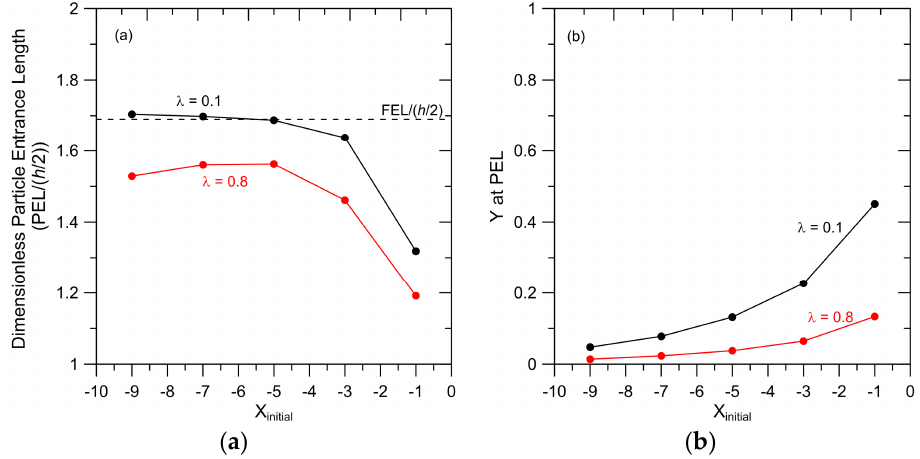
Figure 4. ( a ) Particle entrance length (PEL) as a function of X initial and ( b ) Y at PEL as a function of X initial for particles with λ = 0.1 and λ = 0.8. Particles were initially placed at Y initial = 1 and particle specific gravity = 1.1. The radius of curvature of the pore entrance, r c /( h /2) =1.